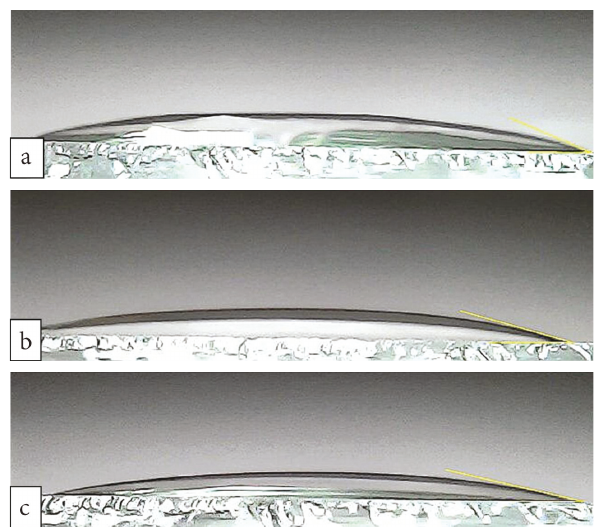
Figure 4: Images of contact angles of 1.0 wt.% chitosan solution: